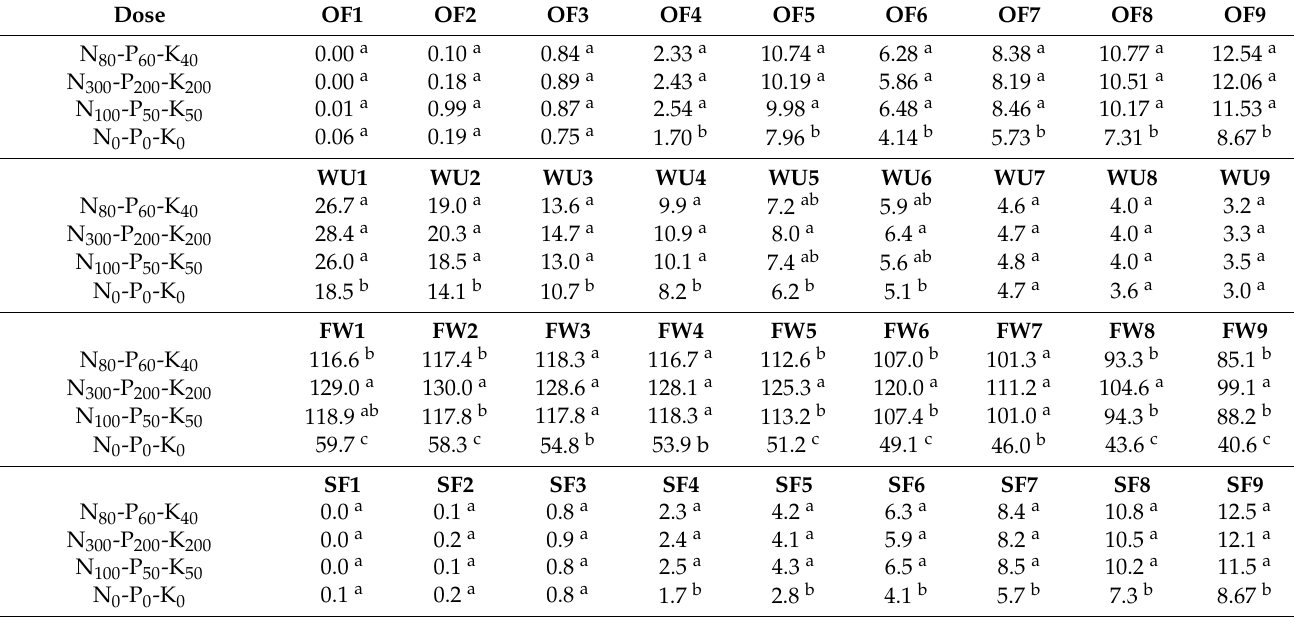
Table 8. Number of open flowers (OF), water uptake (WU), flower weight (FW), and senescent flowers (SF) over a period of 9 days (1–9) in vase of tuberose grown with different doses of